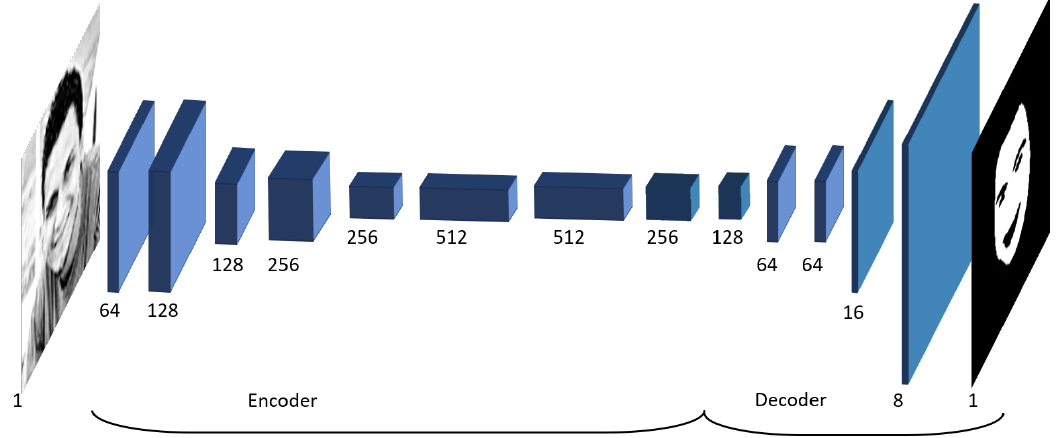
Figure 2. Facial skin network topology. For each layer, the number of filters is